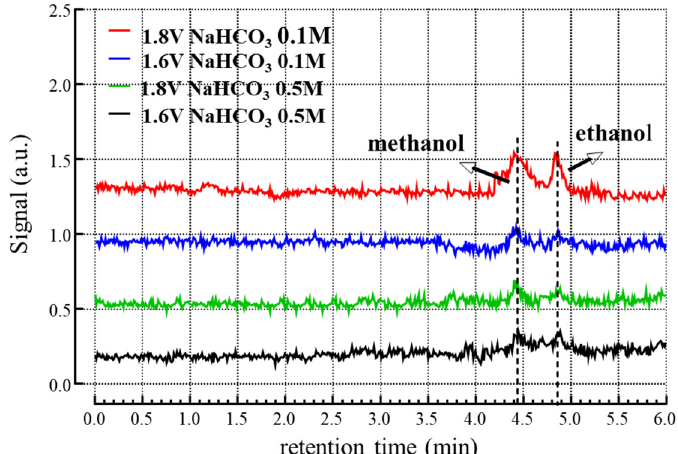
Figure 8. Liquid-phase analysis at the cathode outlet (CuOx/KB-Sustainion X37-50-NiFeO/KB), in the presence of 0.1 M and 0.5 M NaHCO 3 feed at different potentials.